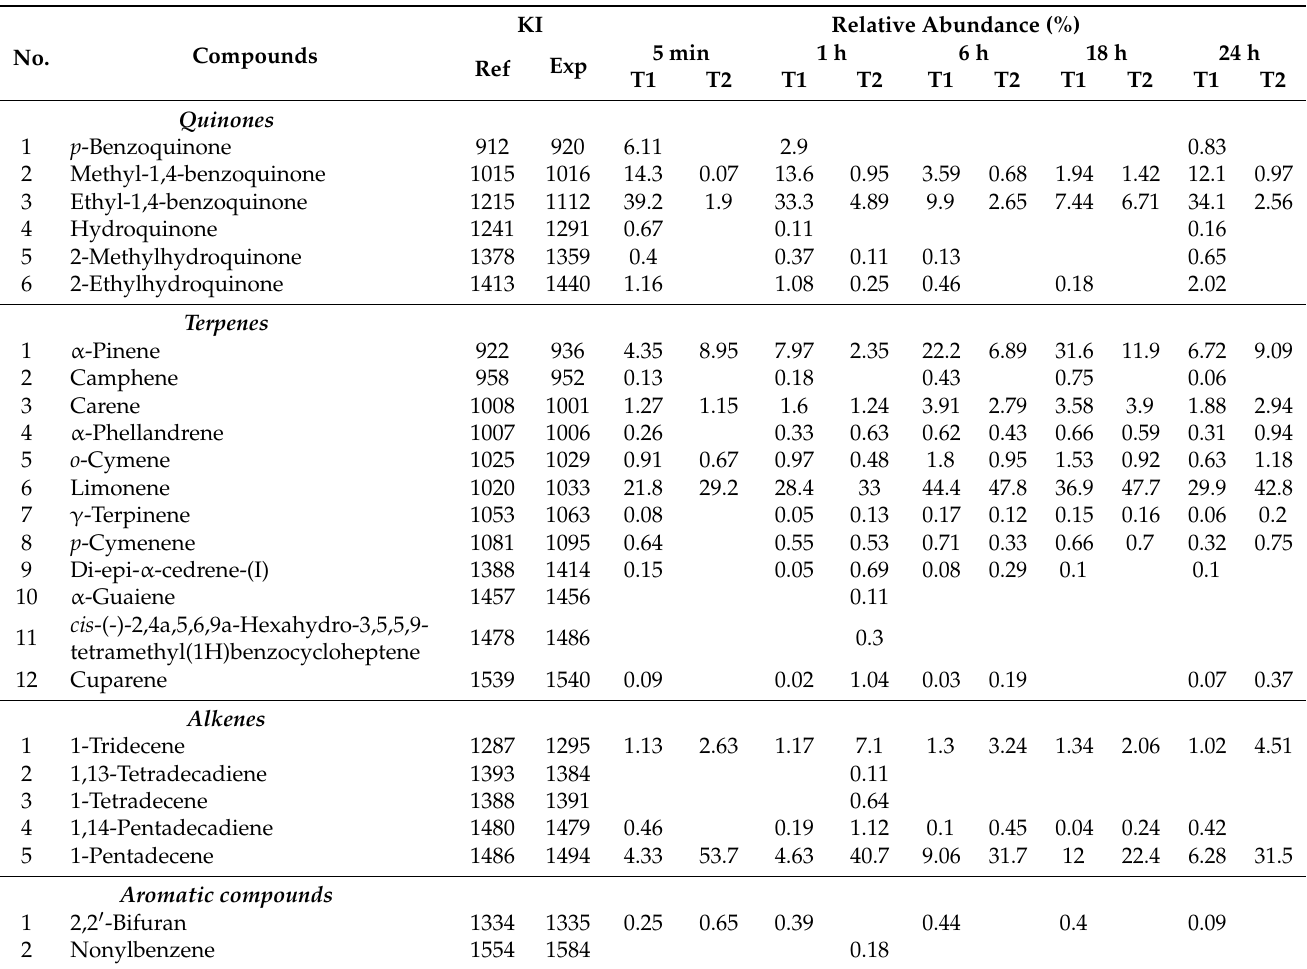
Table 1. VOCs produced by U. dermestoides and collected with CAR/PDMS